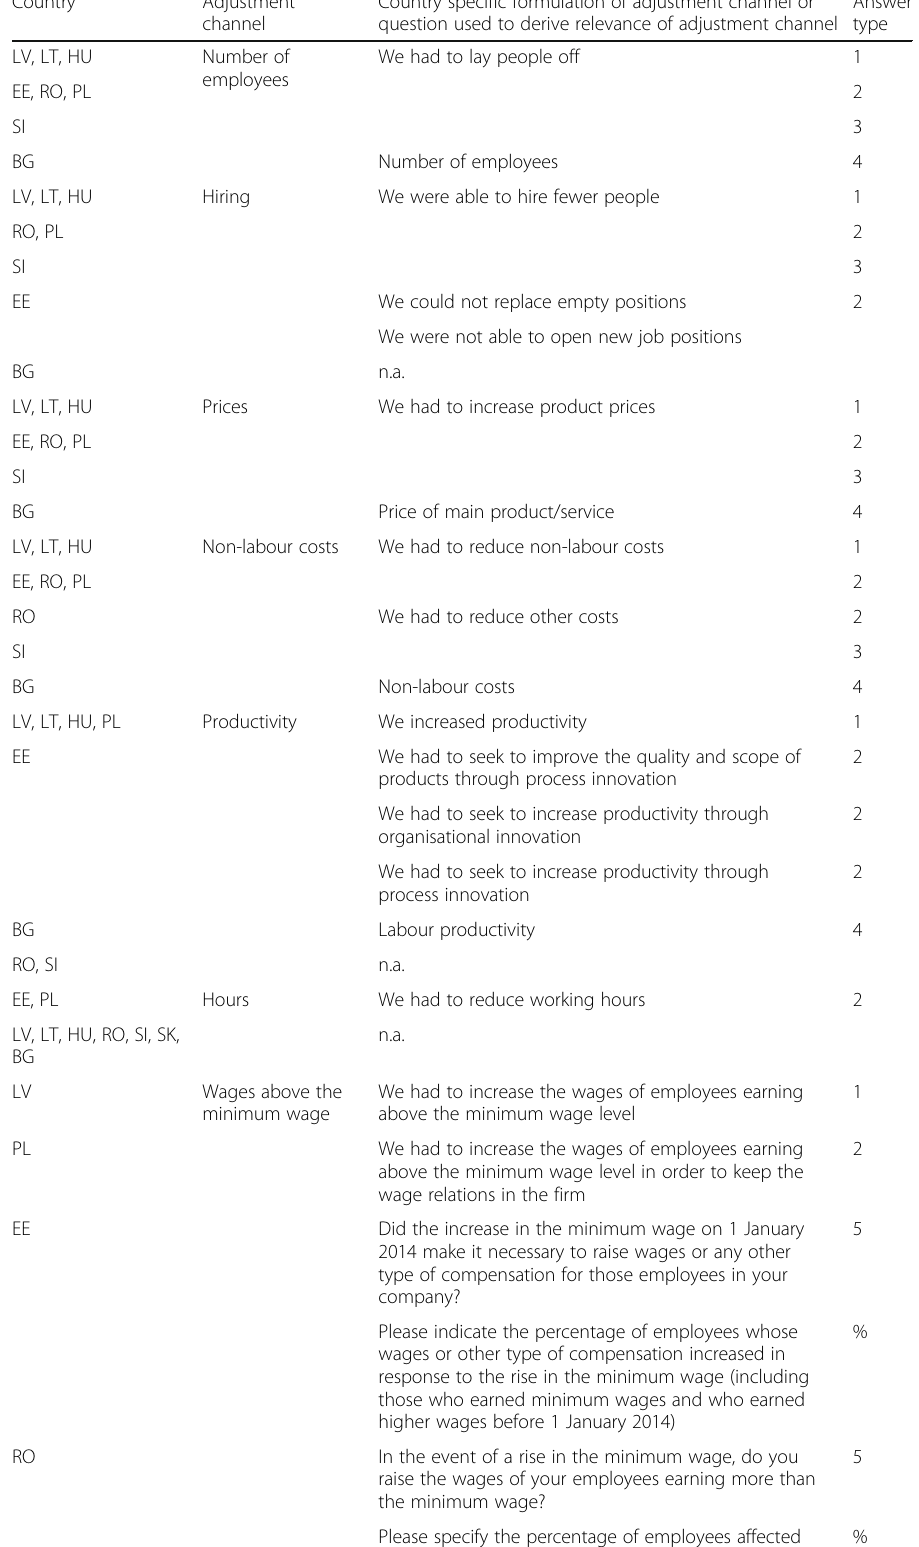
Table 8 Country-specific questionnaires: adjustment channels and answer options